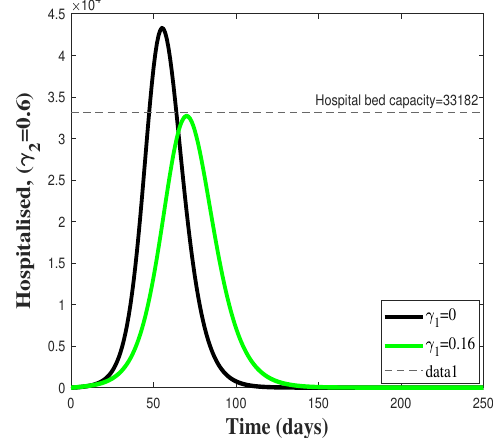
Fig. 6: Population level plots for hospitalized in- dividuals for varying values of γ 1